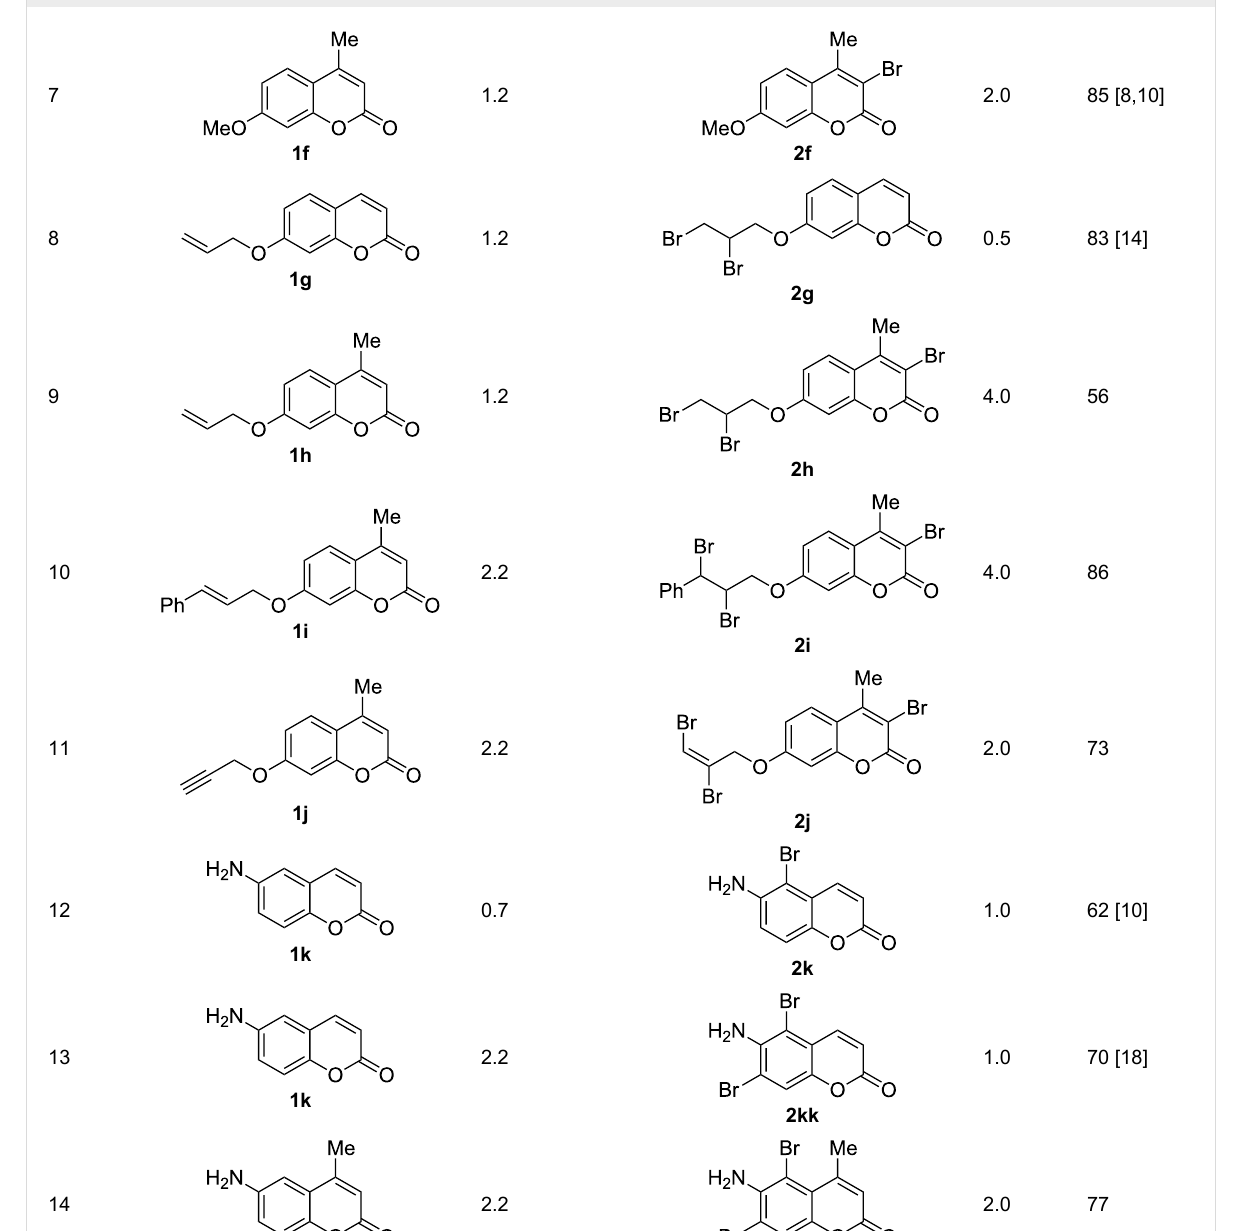
Table 1: Solvent-free reactions of substituted coumarins with dioxane dibromide.